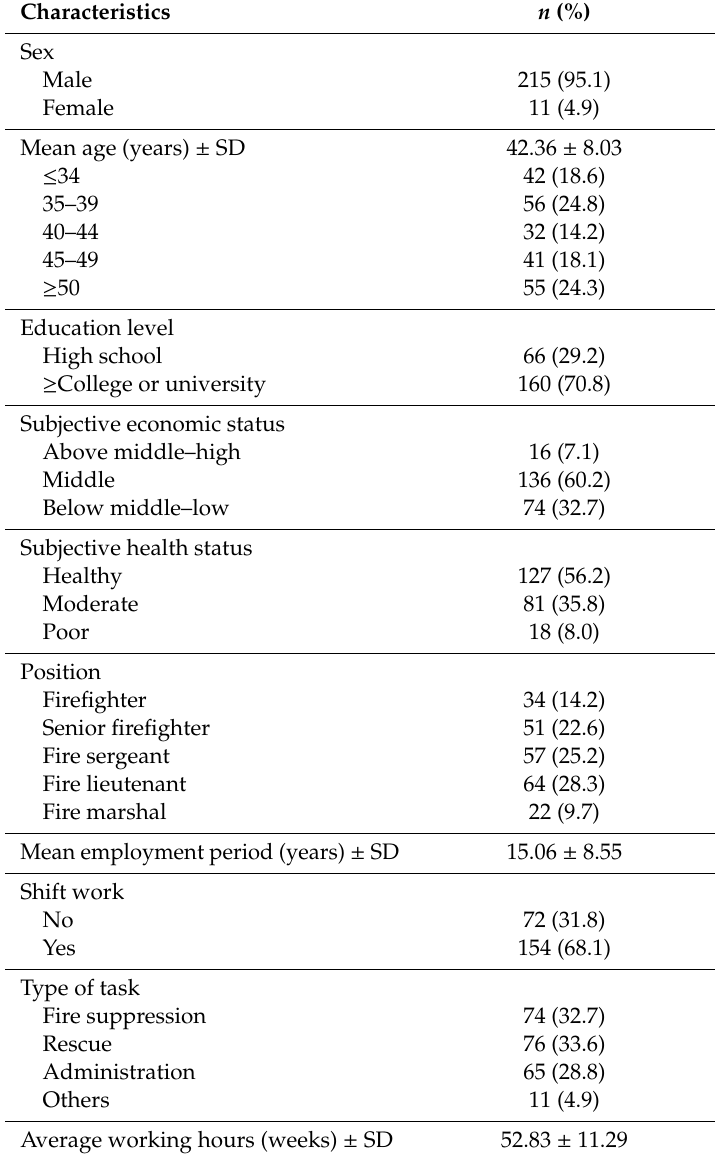
Table 1. General and job-related characteristics of